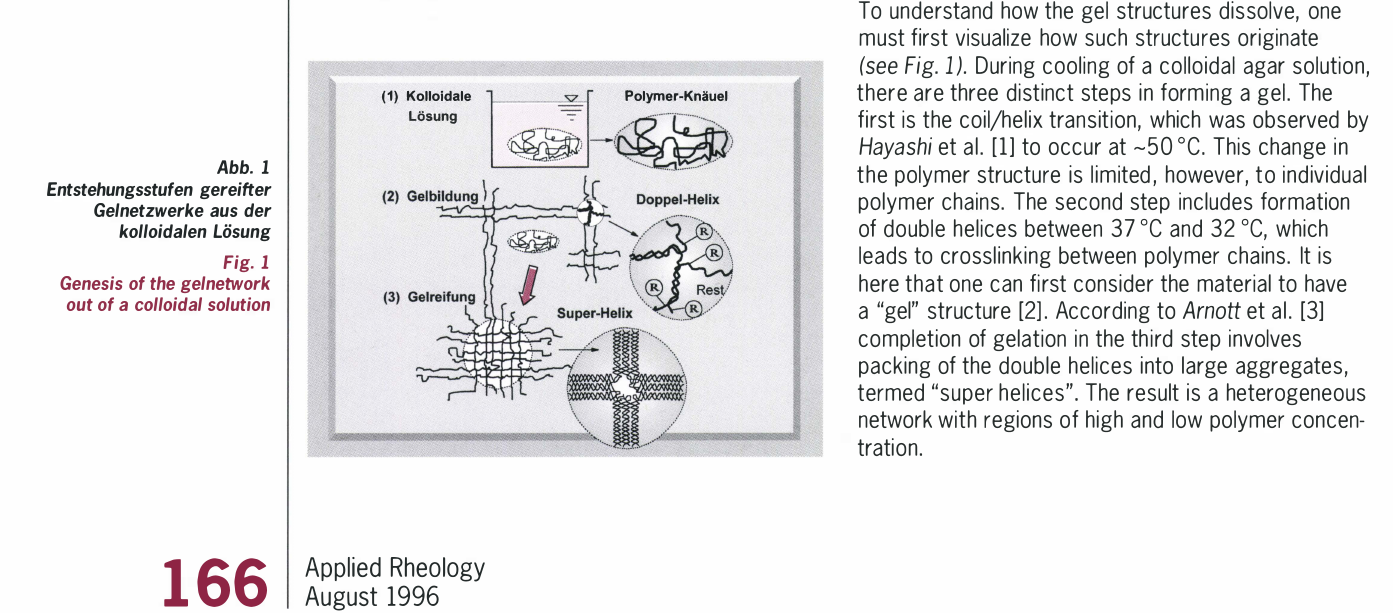
Fig. 1 Genesis of the gelnetwork out of a colloidal